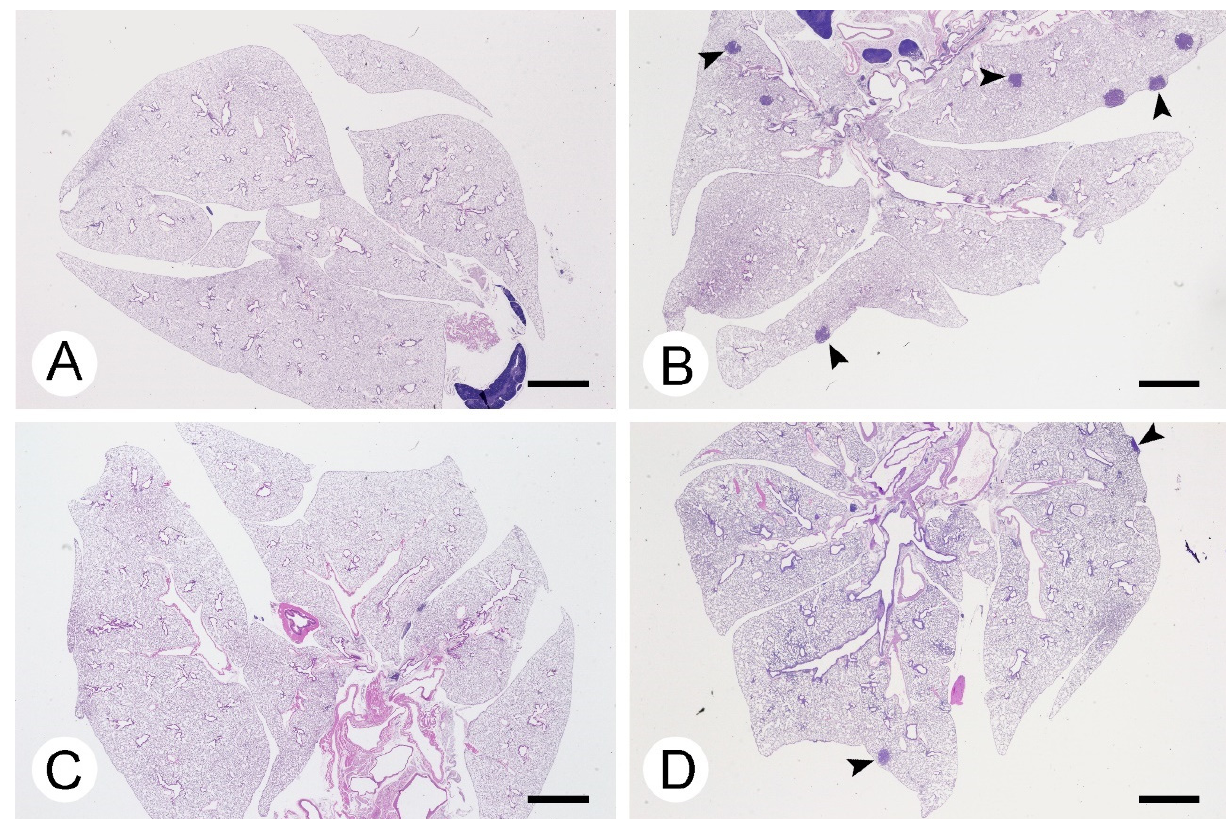
Figure 2. Adenoma development in mice treated with urethane. No tumors are observed in the control ( A ) and in vanadium ( C ) groups. Arrow heads ( (cid:228) ) indicate the adenomas in urethane ( B ) and urethane–vanadium ( D ) groups. Hematoxylin–Eosin. Bar 2mm.